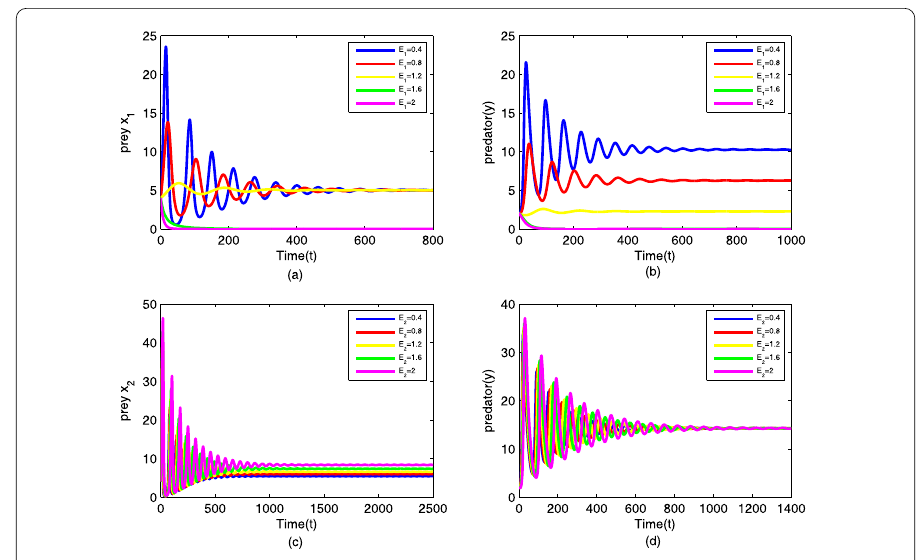
Figure 12 Path of the system species as E 1 ( E 2 ) increases. ( a ), ( b ) Path of prey species x 1 and predator species y of system (3.1) as E 1 increases (see Table 3) keeping the other parameters unchanged. ( c ), ( d ) Path of prey species x 2 and predator species y of system (3.3) as E 2 increases (see Table 3) keeping the other parameters unchanged